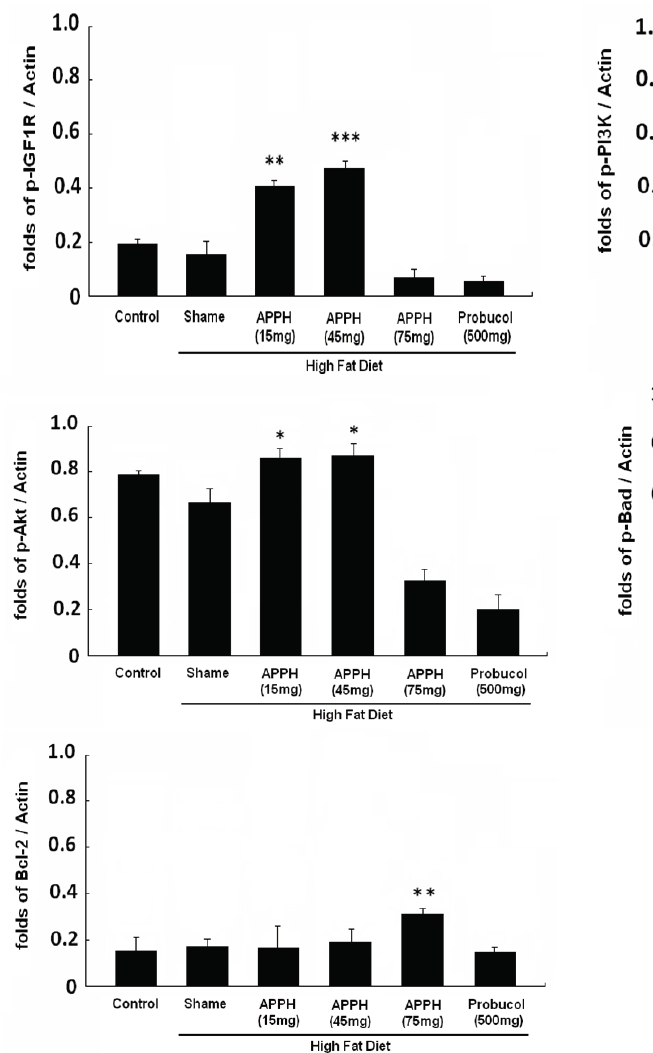
Figure 2. IGF1R-regulated survival pathway signaling analysis. All protein samples from each rat group were analyzed by Western blotting ( n = 3). The protein expression folds were normalized with β -actin. * p < 0.05, ** p < 0.01, *** p < 0.001 compared with the HFD (high-fat diet)